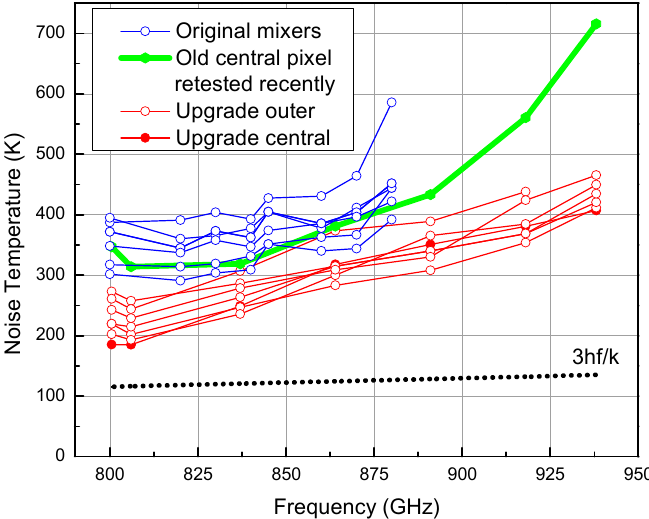
Figure 13. DSB mixer noise temperature for the entire 4–12 GHz IF band vs. LO frequency. The noise temperature is corrected for approximately 10% insertion loss of a beam splitter and the hot LO (300 K) contribution. The old mixers’ performances (blue curves), including the additional recent verification for the central pixel (green curve), are compared here with the results for the new mixers (red curves) [51].